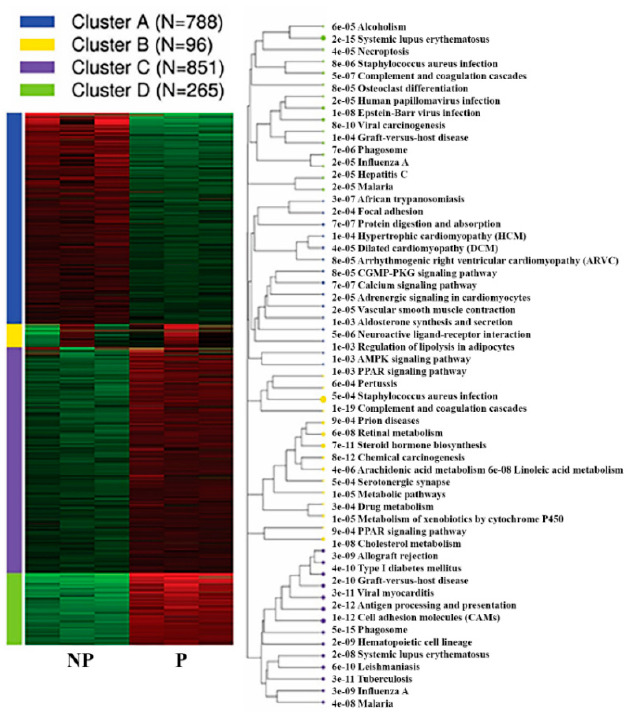
Figure 6. K-means Functional enrichment of differentially expressed genes in the pregnant UA by KEGG pathway alongside the corresponding pathway tree is presented. NP-non-pregnant; P- pregnant.